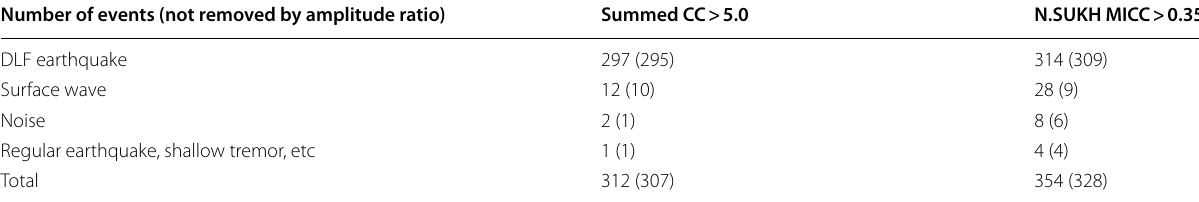
* Numbers in brackets are the total numbers of detected events after removing the surface-wave misdetections (i.e., the amplitude ratio between the 0- to 10-s and 10- to 20-s intervals after the detection onset is larger than one)